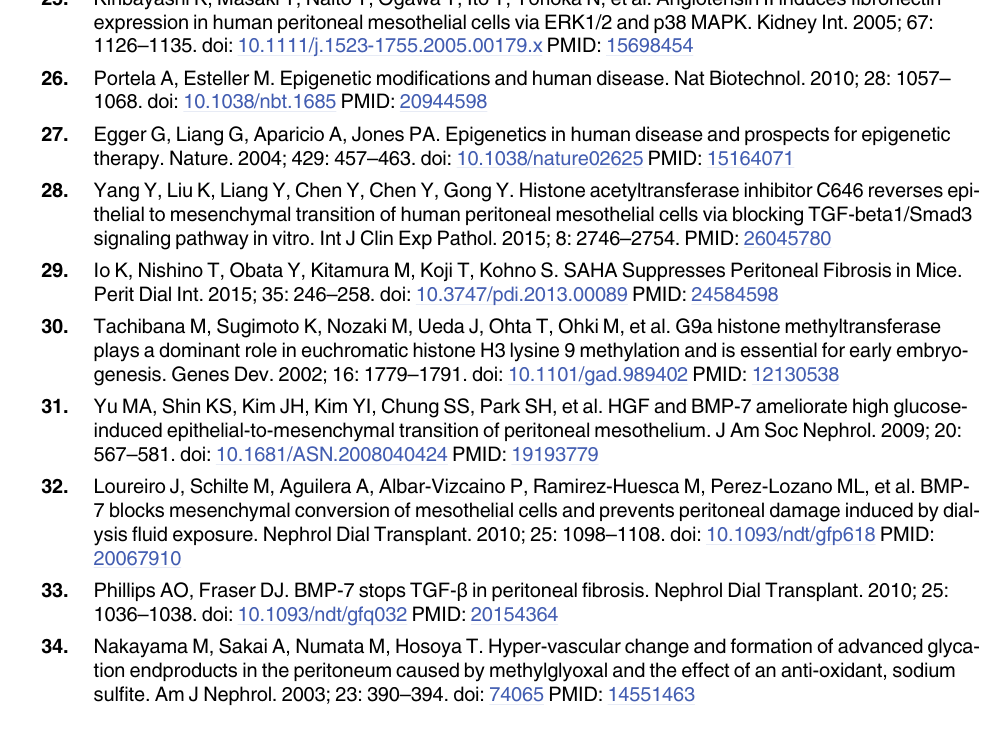
PLOS ONE | DOI:10.1371/journal.pone.0173706 March 9, 2017 13 /